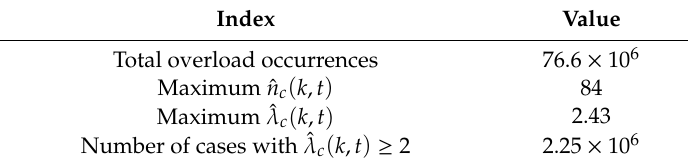
Table 6. Yearly network performances in the N − 1 condition (lines in outage–hours).